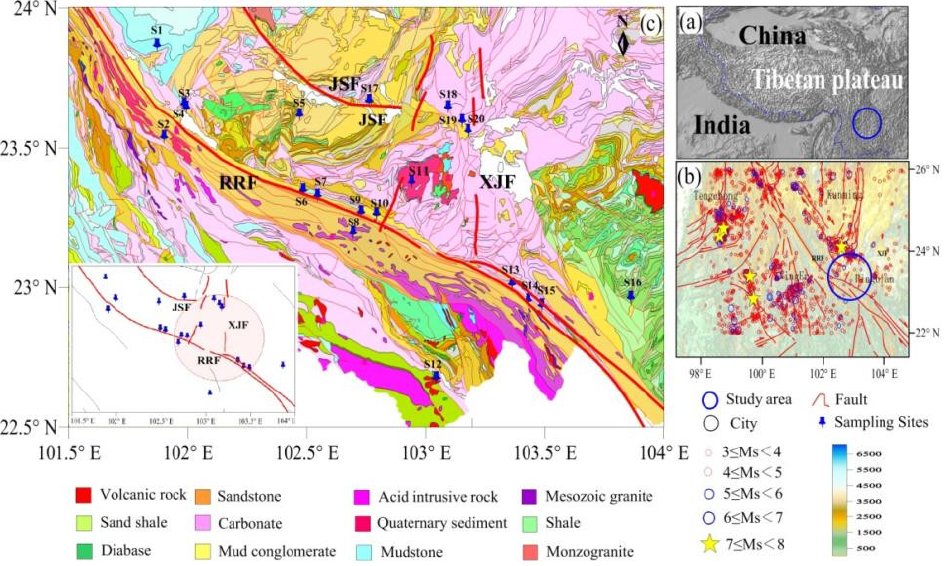
Figure 1. The plot of sampling site distribution. ( a ) Localization of the area of this study. ( b ) Topographic and earthquake distribution map in the intersection of the RRF and the XJF. RRF: Red River Fault Zone; XJF: Xiaojiang Fault Zone; ( c ) Geological map in the intersection of the RRF and the XJF.